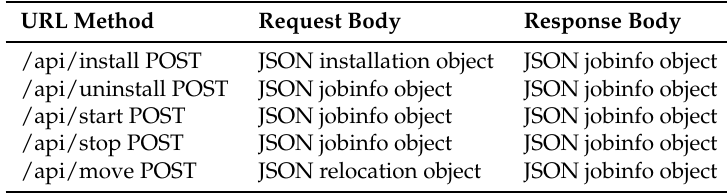
Table 1. Interface Methods of the REST API